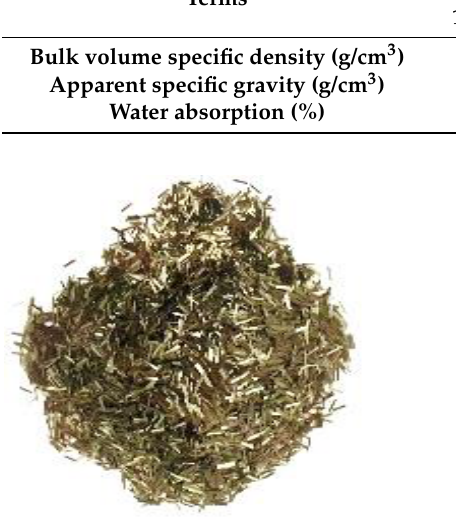
Figure 1. Basalt fiber.